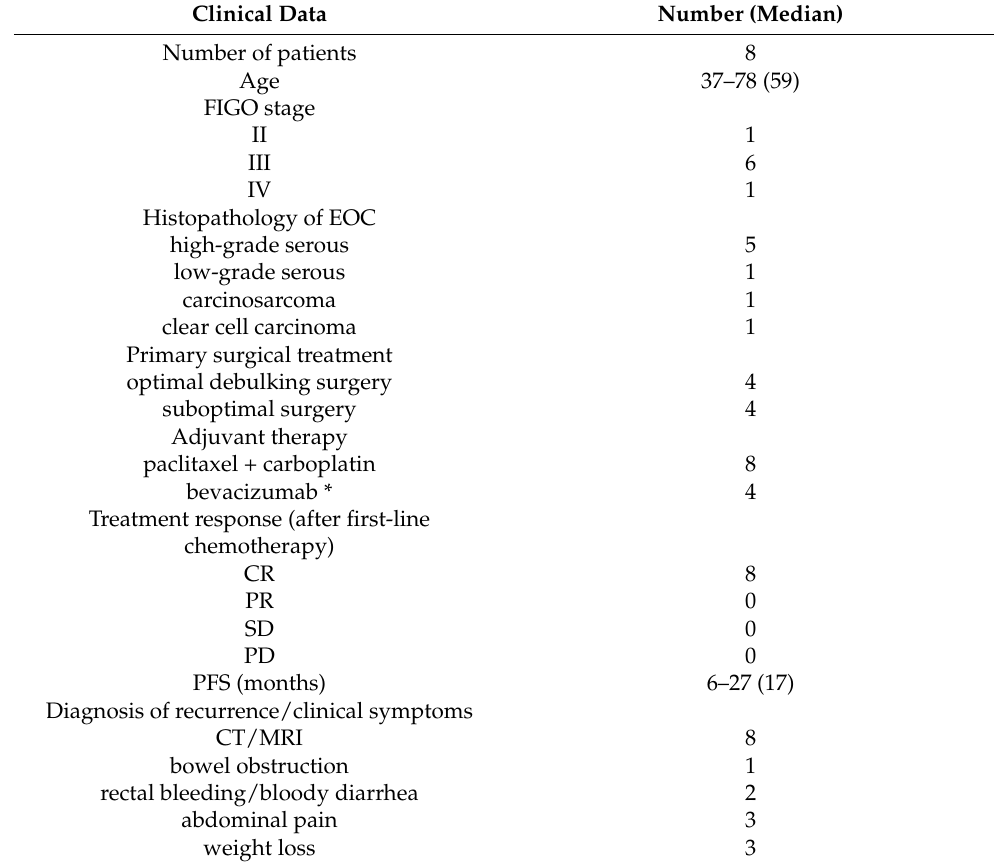
Table 1. Patient characteristics.